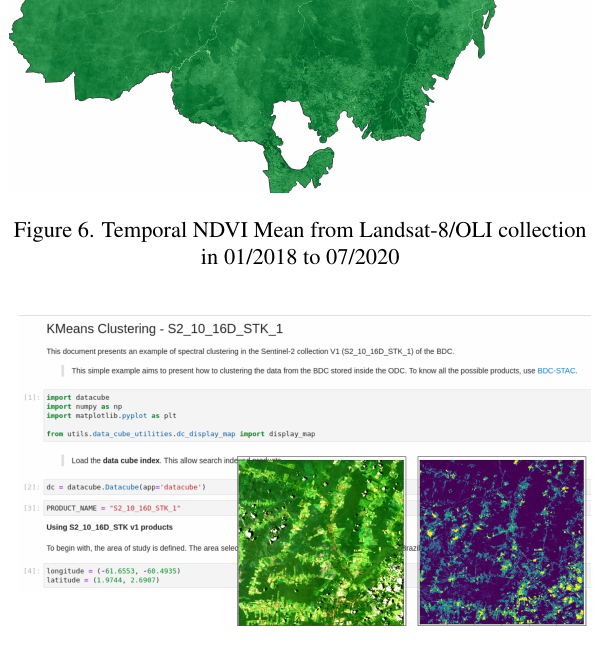
Figure 7. Computational infrastructure used to clustering Sentinel-2/MSI pixels in Roraima state,